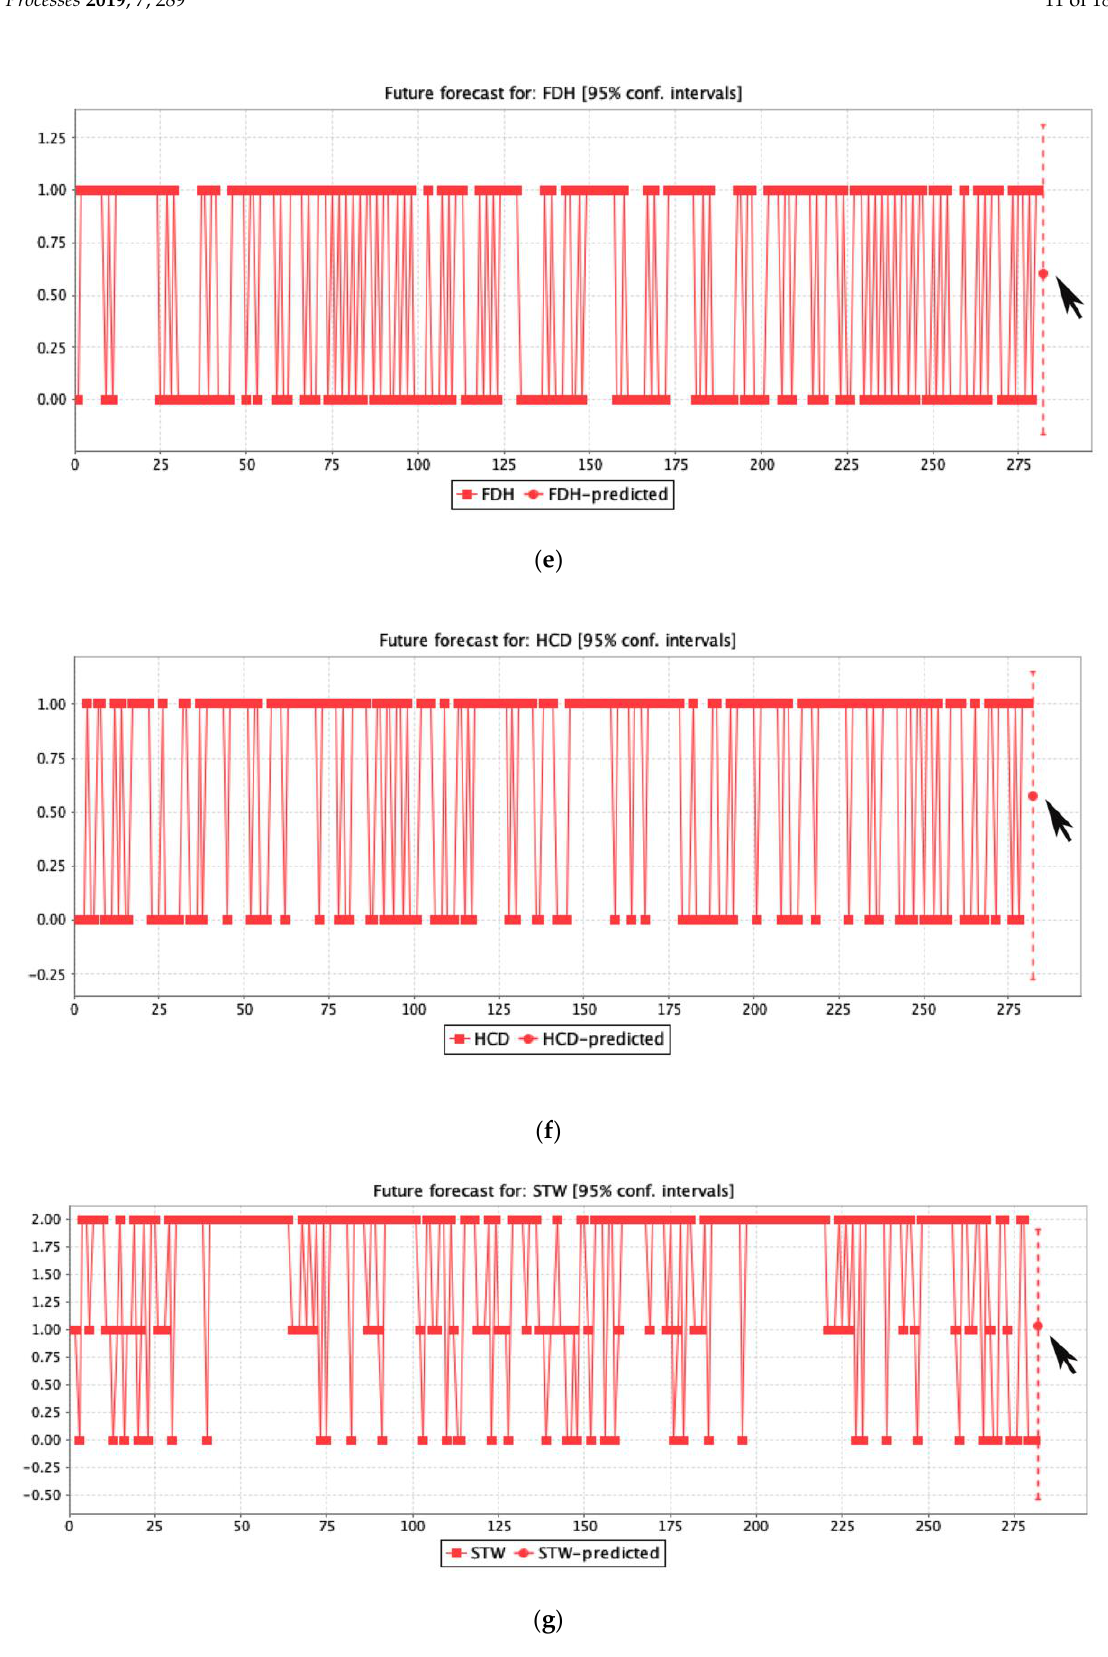
Figure 5. (a – g) The regression prediction assessment of the seven main features used for the analysis of clinical significance.